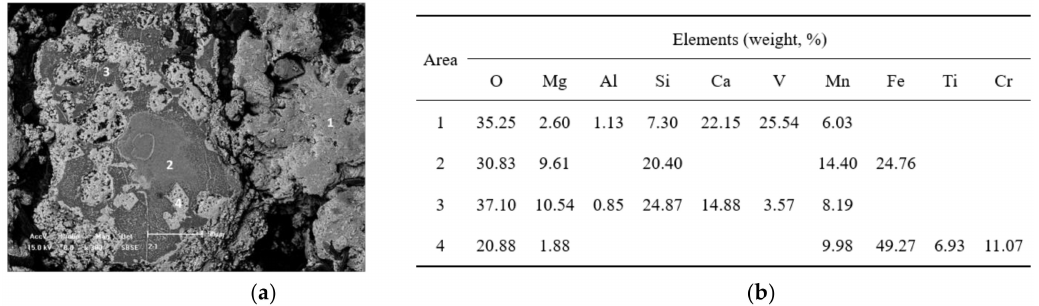
Figure 4. SEM-EDS analysis for the sample roasted at 850 ◦ C for 150 min ( a ) the scanning electron micrograph of the roasted slag; ( b ) the energy dispersive spectrum analysis for different areas in Figure 4a.